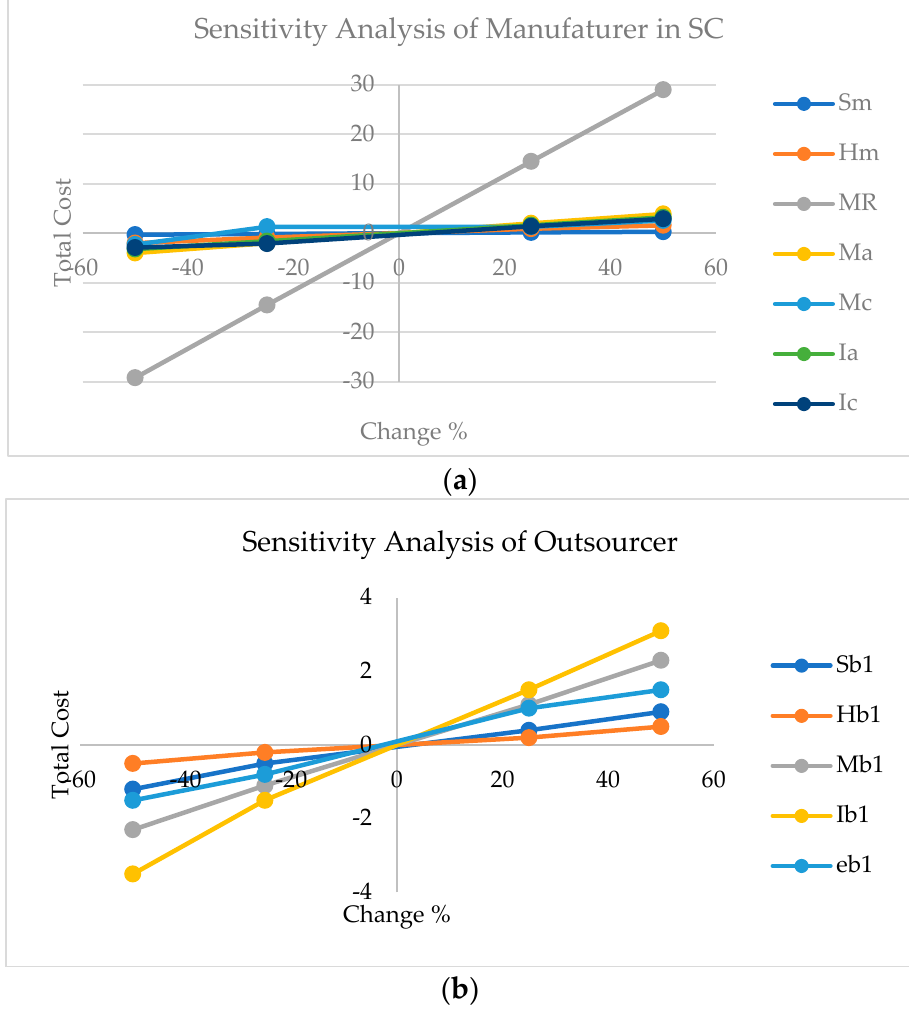
Figure 2. Graphical representation of sensitivity analysis: ( a ) manufacturer ( b ) outsourcer .